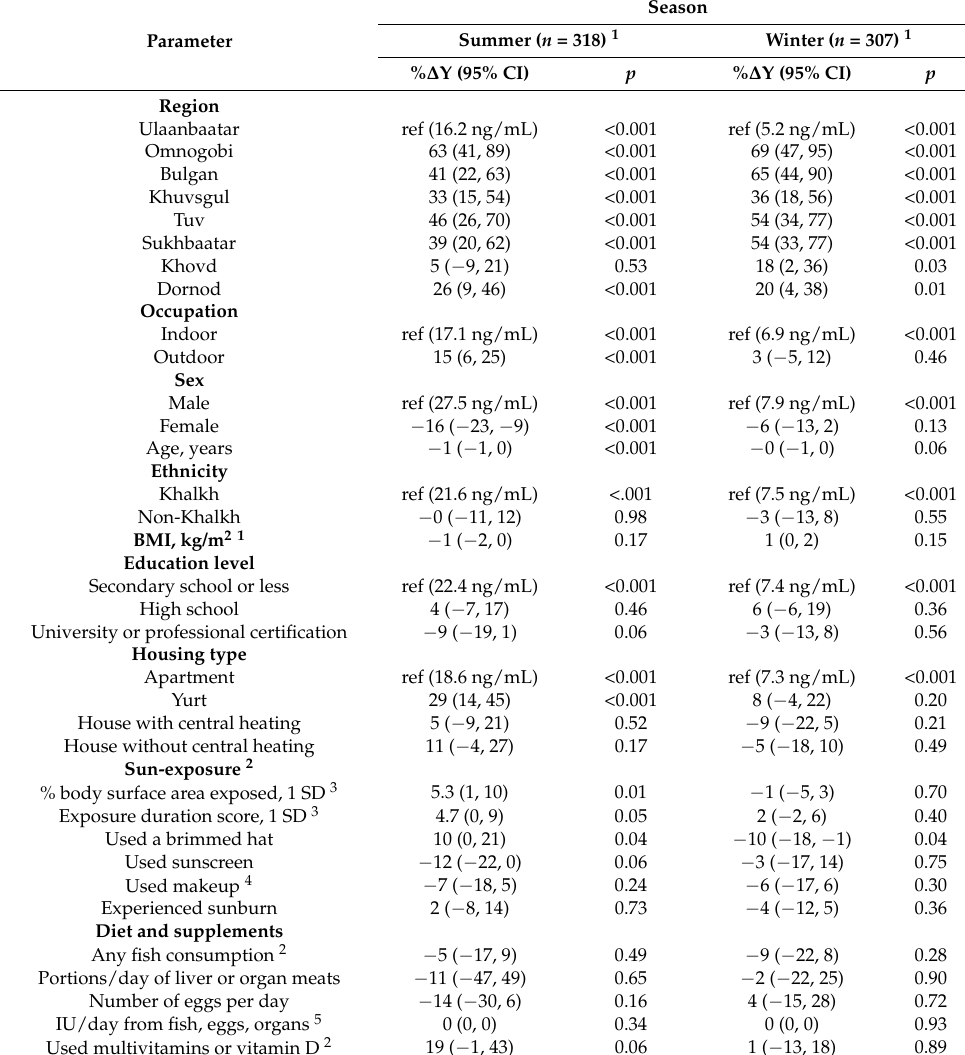
Table 3. Unadjusted percent difference in 25(OH)D concentration by exposure to demographic and seasonal